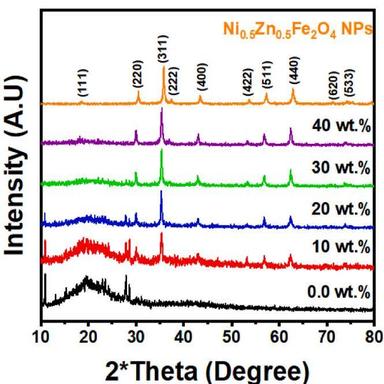
XRD analysis for nanoparticles and Polyester doped different concentrations of Ni0.5Zn0.5Fe2O4 nanoparticles (0.0, 10.0, 20.0, 40.0 wt%).